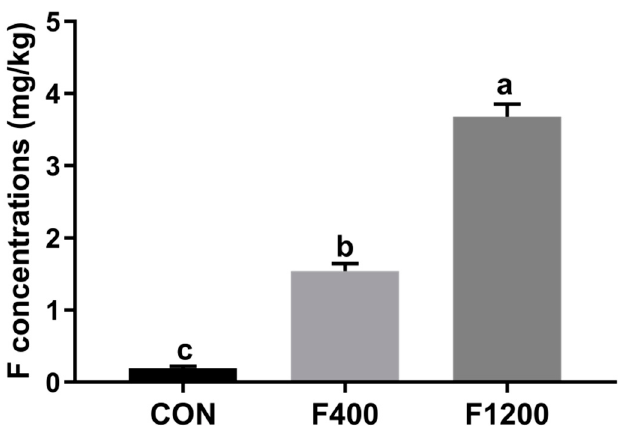
Figure 1. Effects of dietary fluoride (F) level on the contents of F in the duodenum. Values were showed as the means and SD ( n = 6). a–c Means with different superscript letters are significantly different ( p < 0.05). CON, the control group, basal diet; F400 and F1200, diets supplemented with 400, and 1200 mg F/kg feed from sodium fluoride, respectively.